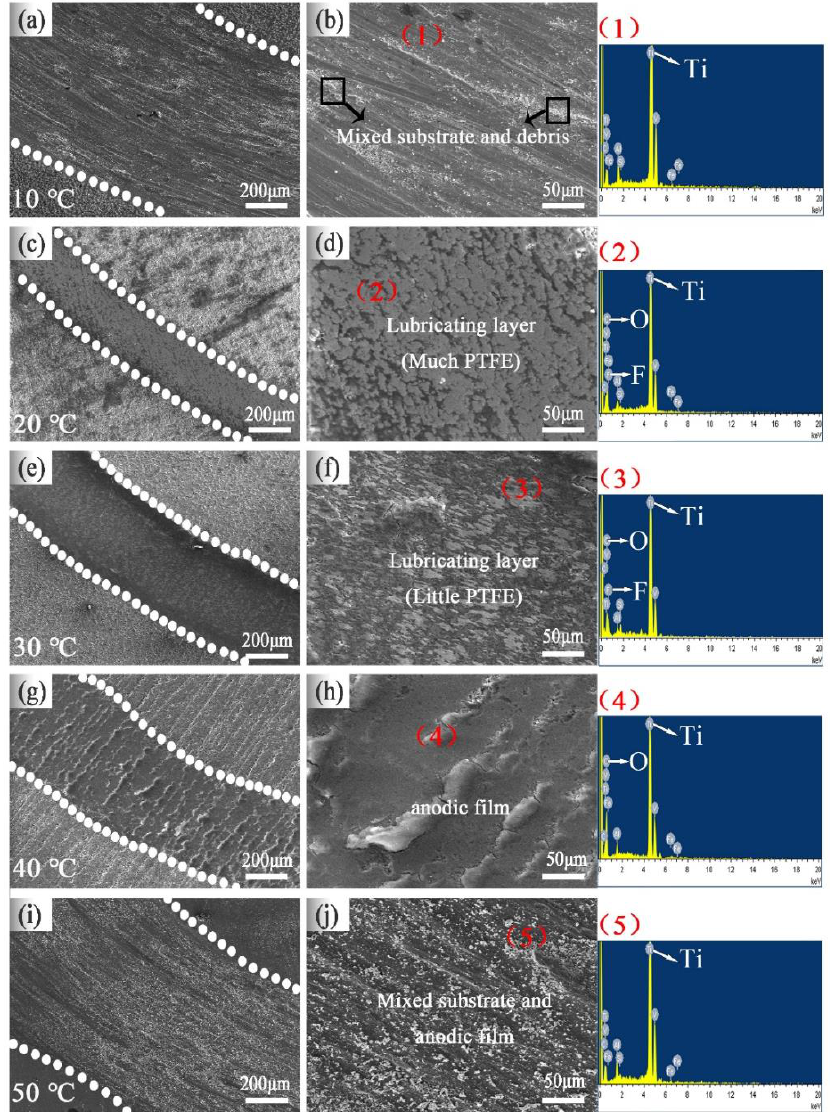
Figure 12. The SEM and EDS images of the worn surface for composite anodic films fabricated at different temperatures: ( a , b ) ( 1 ) 10 °C; ( c , d ) ( 2 ) 20 °C; ( e , f ) ( 3 ) 30 °C; ( g , h ) ( 4 ) 40 °C; ( i , j ) ( 5 ) 50 °C.